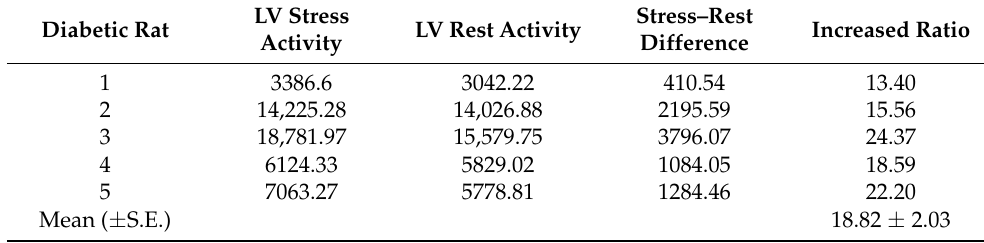
Table 3. Tracer activity (Bq/mL) in the segmented LV intra-myocardial vascular volume in stress and rest conditions and relative percentage stress-related increase in LV intra-myocardial vascular volume (“stress–rest difference”) after regadenoson injection in the diabetic rats. Stress–rest difference is calculated on a pixelwise level, as detailed in the Materials and Methods